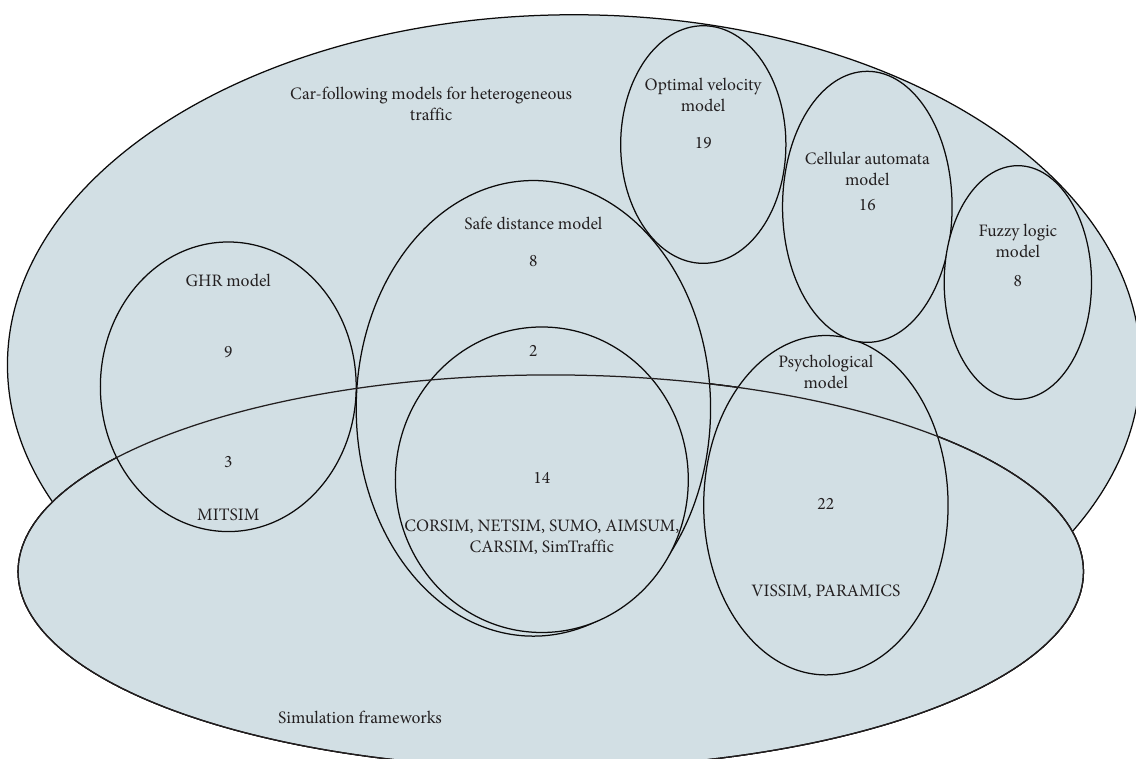
Figure 2: Venn diagram of a number of literature works